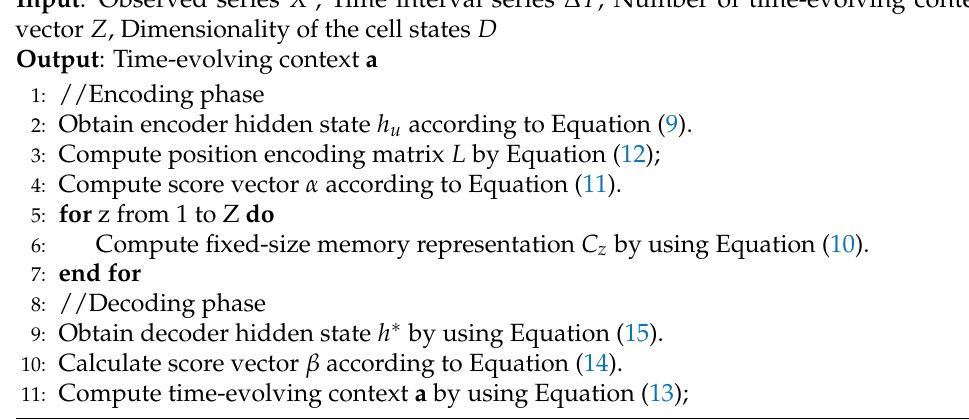
Algorithm 1 outlines the calculation process for the time-evolving context. First,